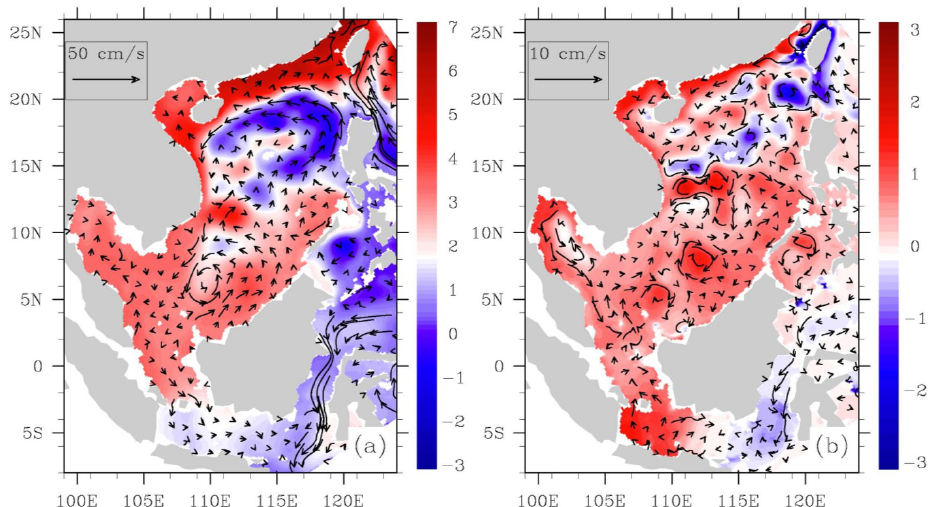
Fig. 2. Comparison of the daily averaged SLA and surface currents during 1994–1995: (a) the mean state without tidal forcing, (b) the SLA and surface current difference for two model simulations, one with tidal forcing and the other without. These two free model runs use the same initial conditions and run from January 1992 to December